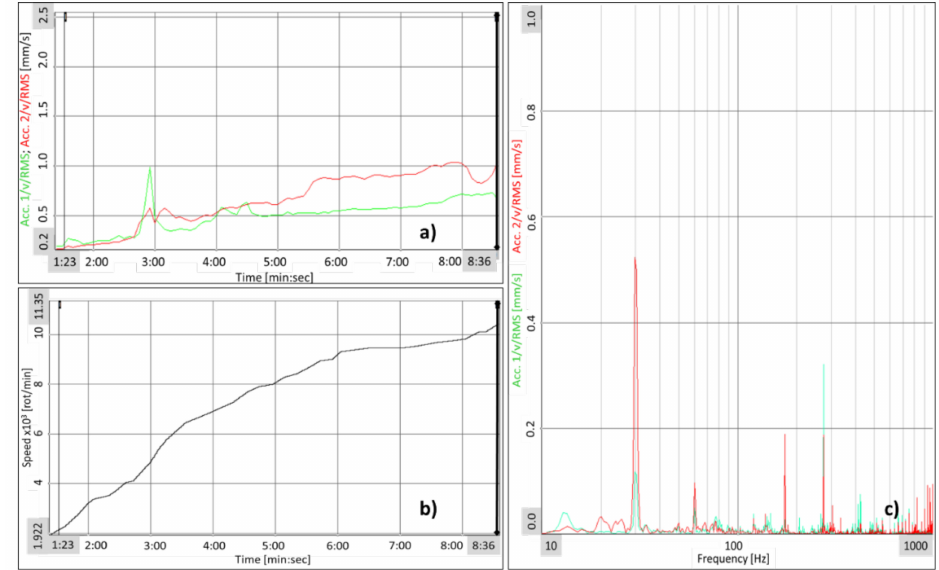
Figure 23. ( a ) Vibration level variation over time; ( b ) Speed variation over time; ( c ) Spectral analysis of speed (11,353 rot/min) corresponding to cursor location from ( a ) and ( b